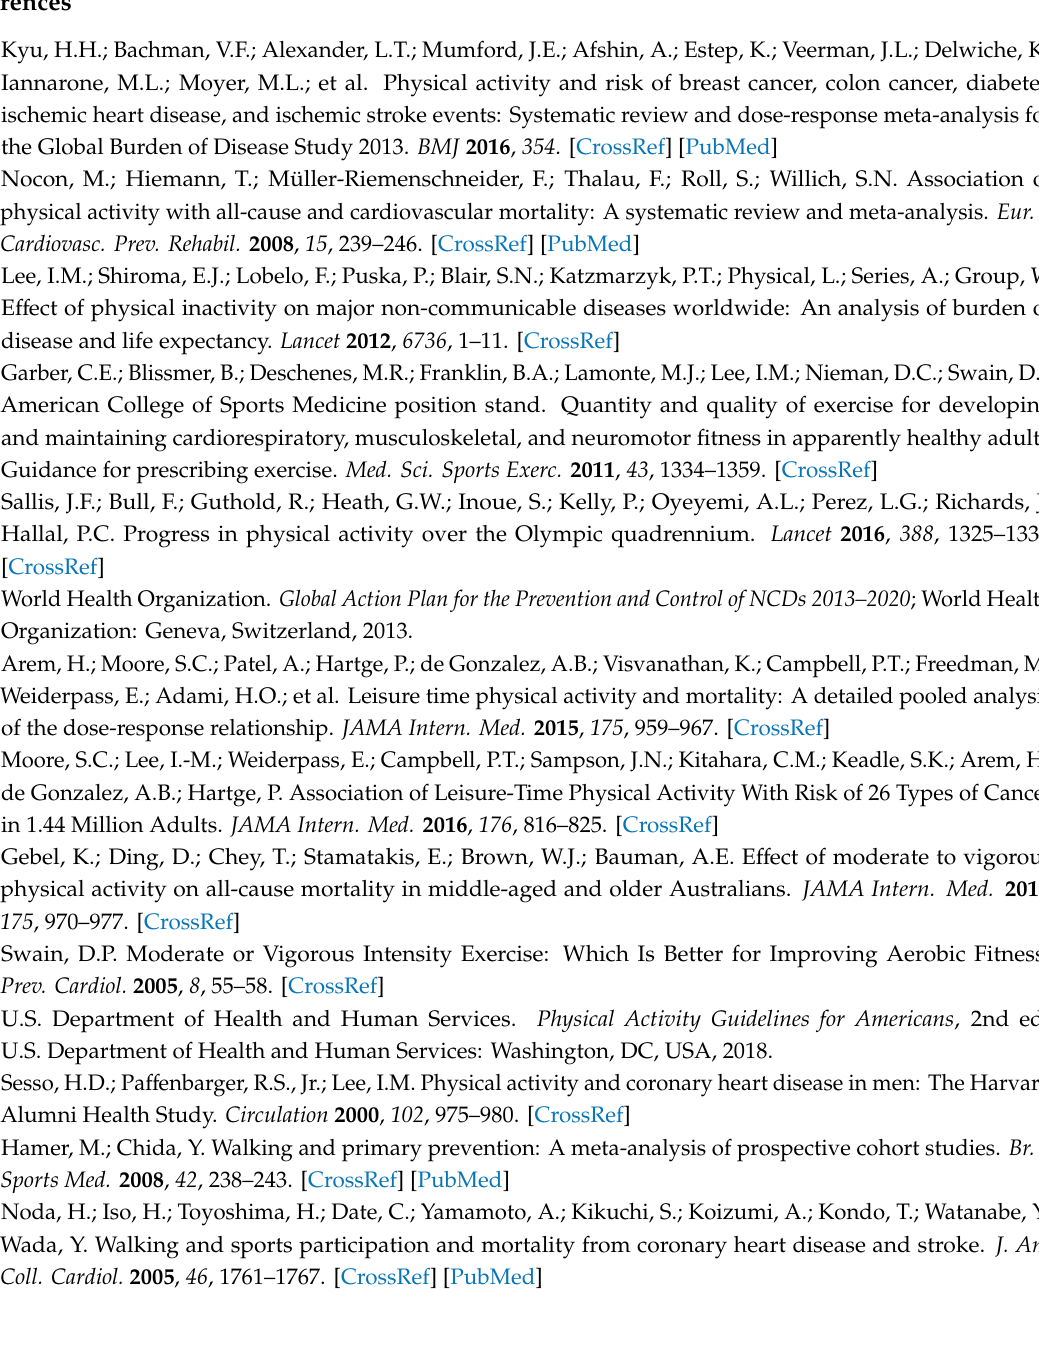
Table S1:Associationbetweencardiometabolicmeasuresandtotalleisuretimephysicalactivity(LTPA),stratified by ethnicity; Table S2: Association between cadiometabolic measures and leisure time physical activity (LTPA) subtypes, stratified by